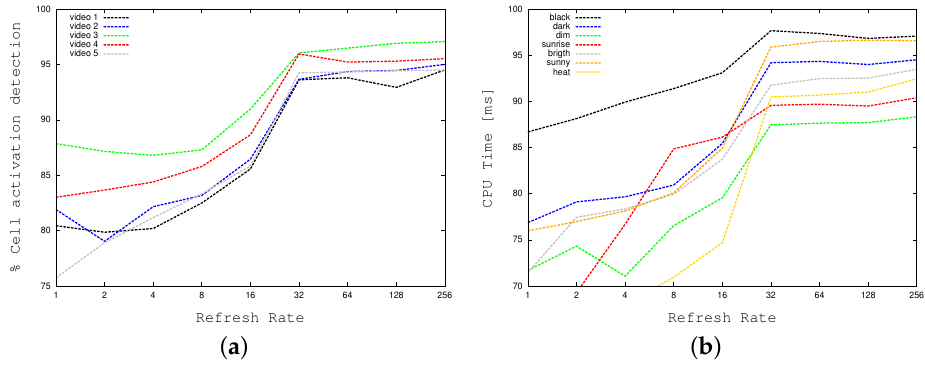
Figure 14. Cell activation detection as a function of the refresh rate: ( a ) Standard weather, ( b ) Black, dark, dim, sunrise, bright, sunny, heat weather conditions.